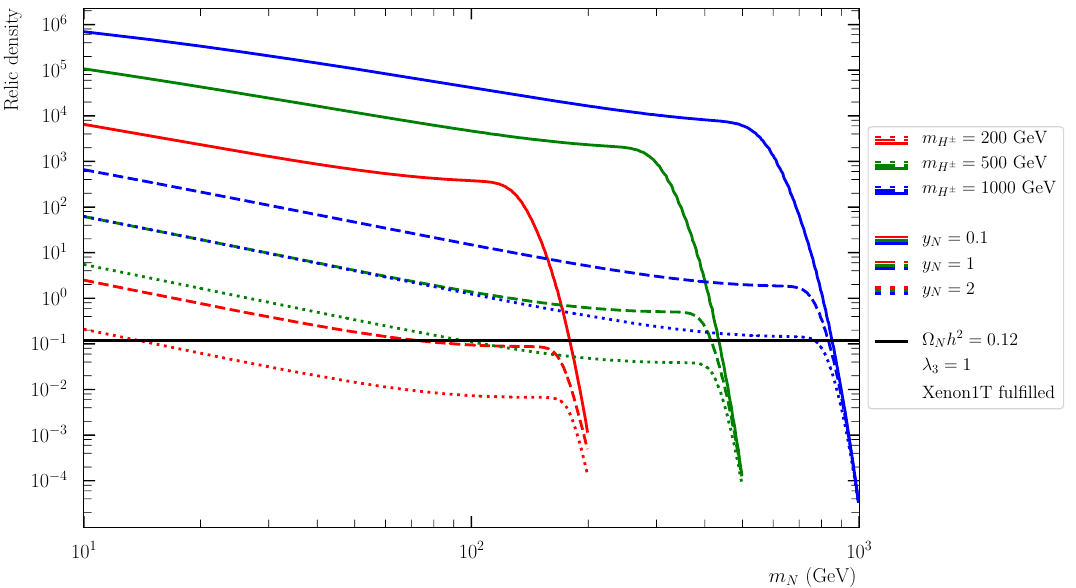
Figure 3 . Dependence of the DM relic abundance as a function of its mass m N for various values q of y = + y 2 + y 2 ; the results are shown for y = 0 . 1 y 2 ’ y e and the charged Higgs mass m N N H ± e µ τ (solid), y = 1 (dashed), y = 2 (dotted). The color codings for the charged Higgs masses are N N as follows: red lines correspond to m = 200 GeV, green lines to m = 500 GeV and blue lines H ± H ± to m = 1000 GeV. All the values are consistent with bounds from the Xenon1T searches of H ± DM-Nucleon elastic scattering. All the calculations have been done for λ = 1 . The horizontal 3 black solid line corresponds to the Planck measurement of relic density ( Ω 2 = 0 . 12 Planck h